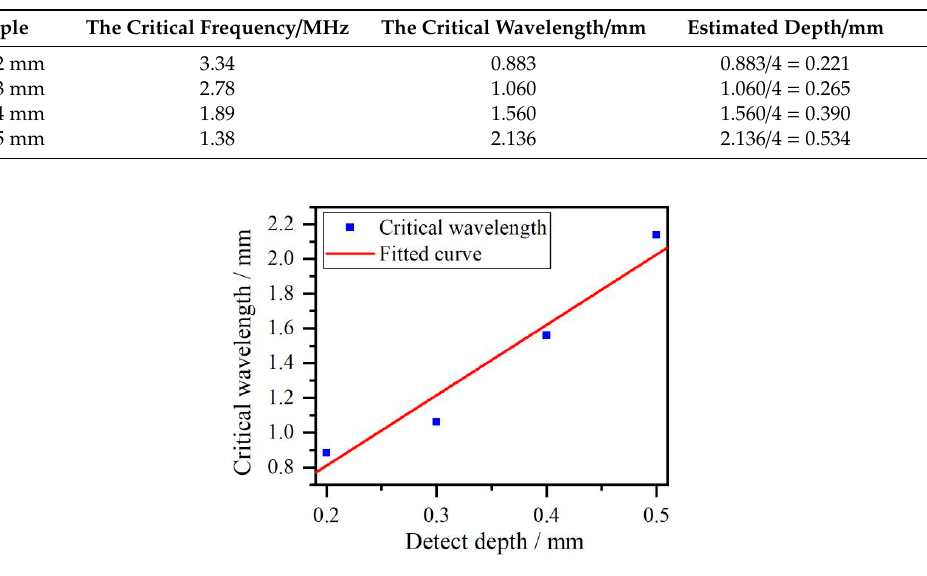
Table 2. Estimated crack depth and relative error.